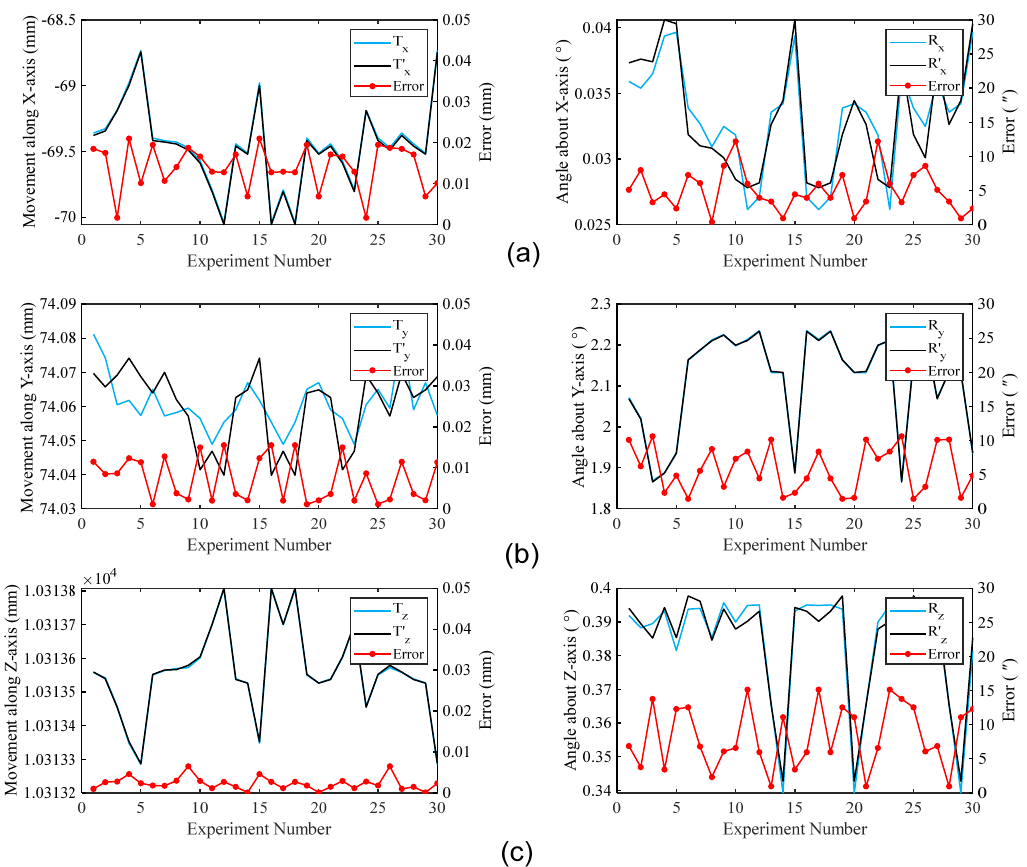
Figure 9. Measurement results and errors of 6-DOF pose (measurement distance is 10 m). Measurement results and errors in ( a ) the x − axis direction; ( b ) the y − axis direction; ( c ) the z − axis direction.